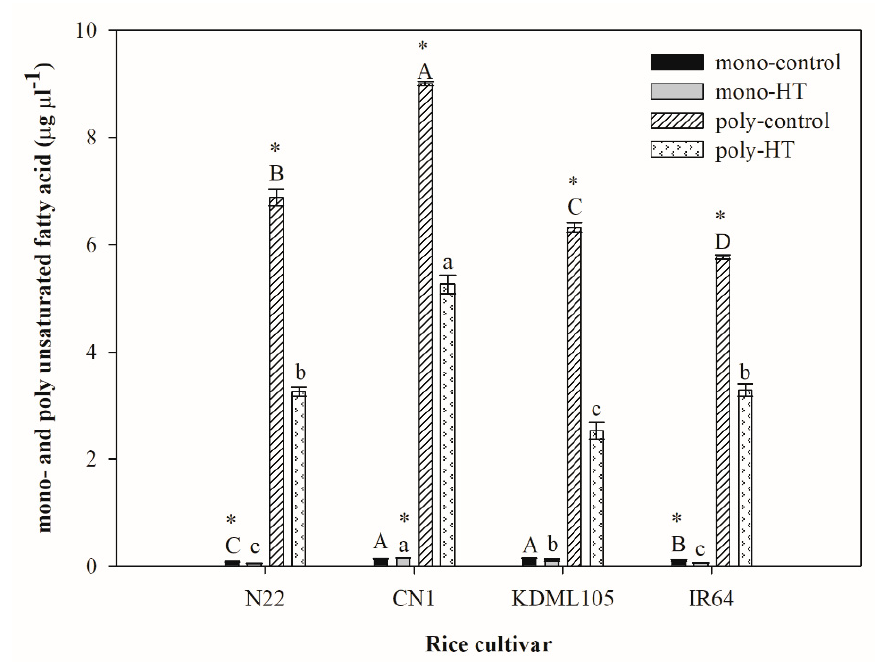
Figure 5. Effect of HT on mono- and polyunsaturated fatty acids in four rice cultivars (N22, CN1, KDML105 and IR64). Each bar represents mean ± SE ( n = 3–4). Asterisk (*) indicates significant difference between control and HT in mono- or poly unsaturated fatty acid and in each rice cultivar at p ≤ 0.05 by t test. Different capital letters indicate significant difference of control group in different rice cultivars at p ≤ 0.05 by ANOVA and DMRT, and small letters indicate significant difference of HT in different rice cultivars at p ≤ 0.05 by ANOVA and DMRT.